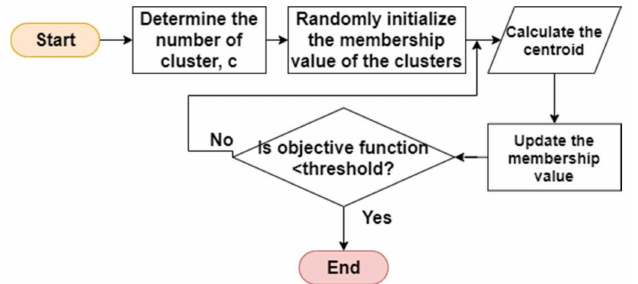
Figure 8. Basic steps of FCM